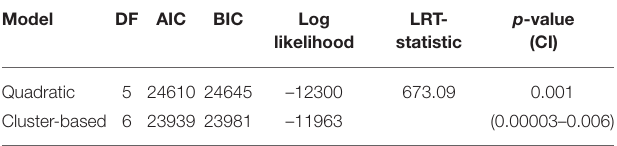
TABLE 2 | Simulated likelihood ratio test